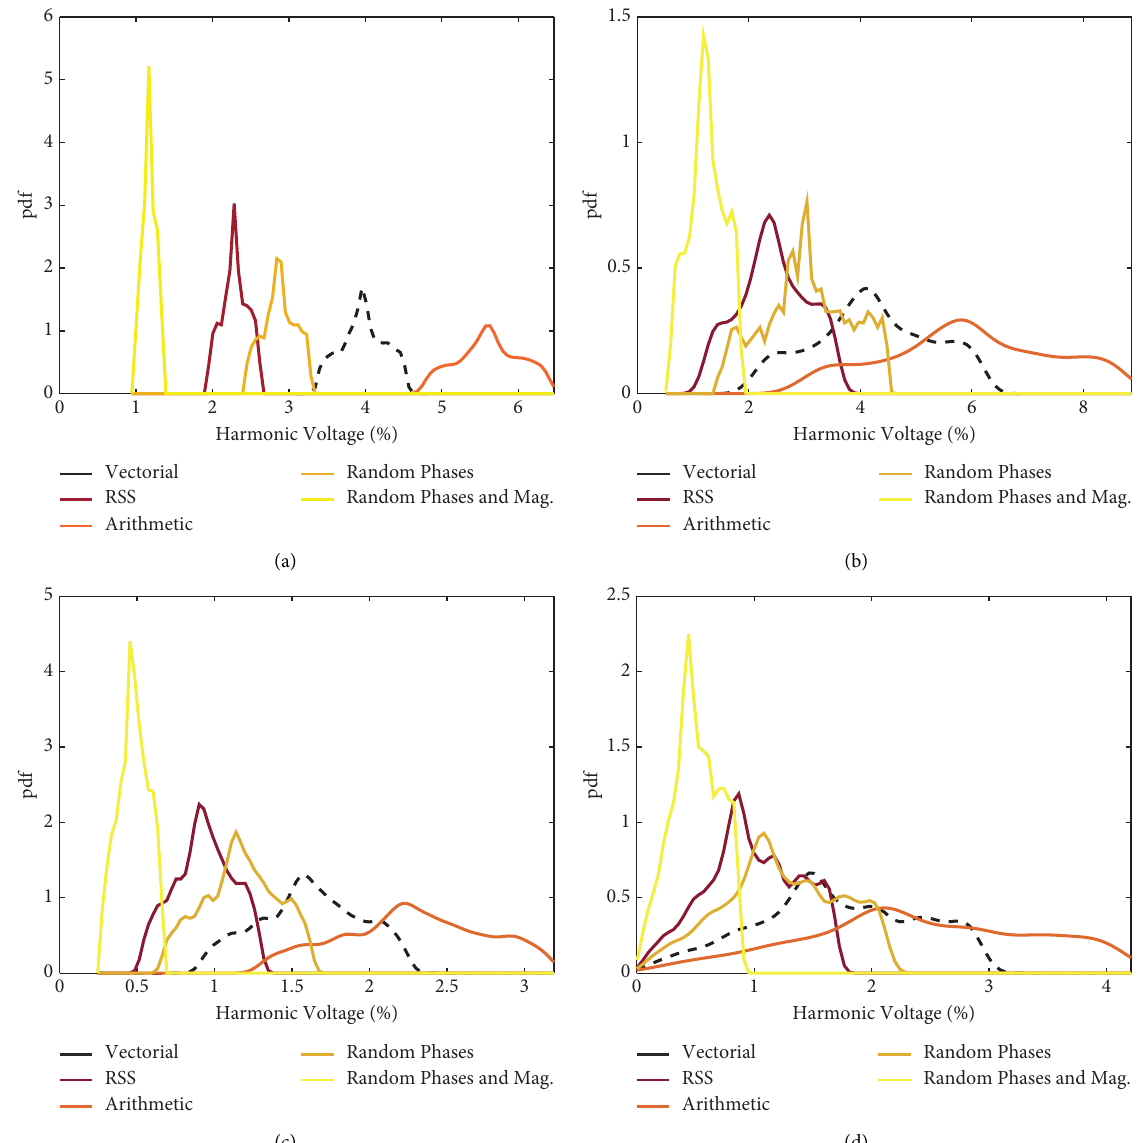
Figure 12: Summation methods pdfs for Case 5 at busbar 5 for 5th harmonic (a), 7th harmonic (b), 11th harmonic (c), and 13th harmonic